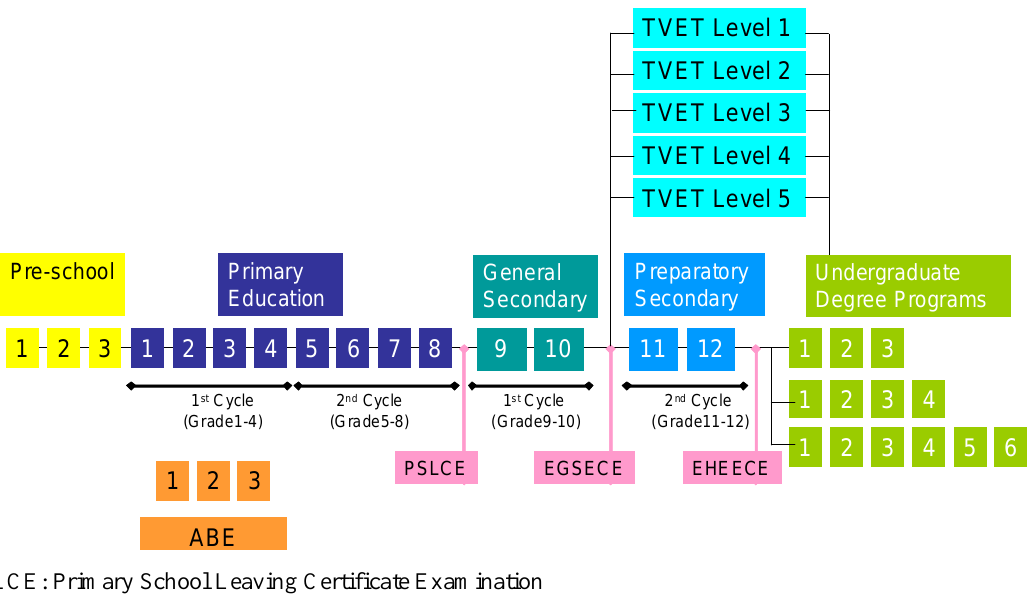
Figure: 3-1 Structure of the Ethiopian Education